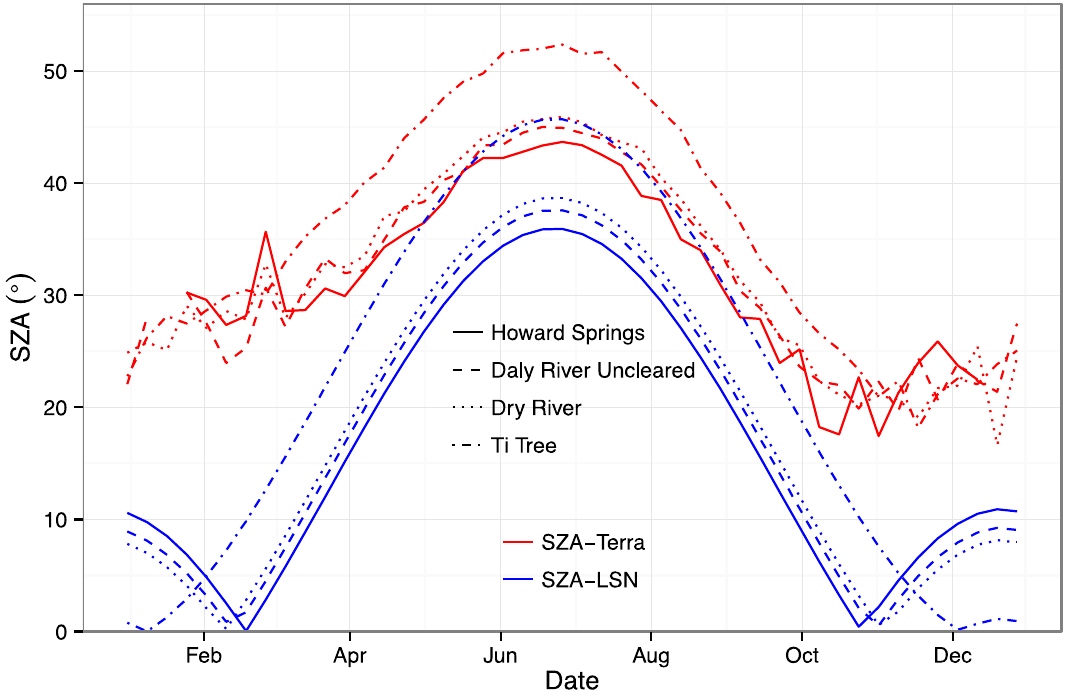
Figure 3. Seasonal variations in solar zenith angle for the Terra satellite (MODIS sensor onboard) overpassing time (~10:30am local time) and the local solar noon at four NATT sites.